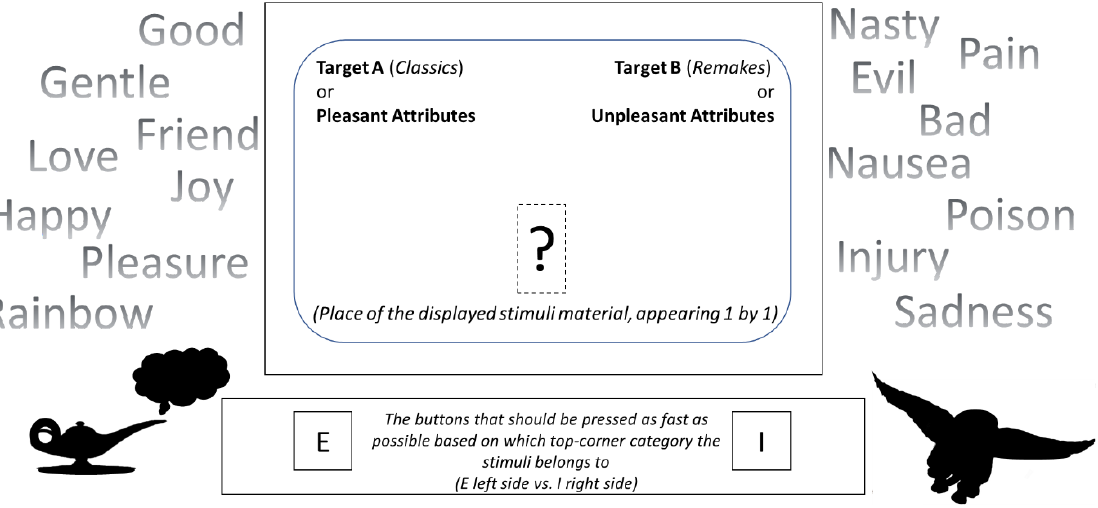
F IGURE 2. T HE IMPLICIT ASSOCIATION TEST IN Q